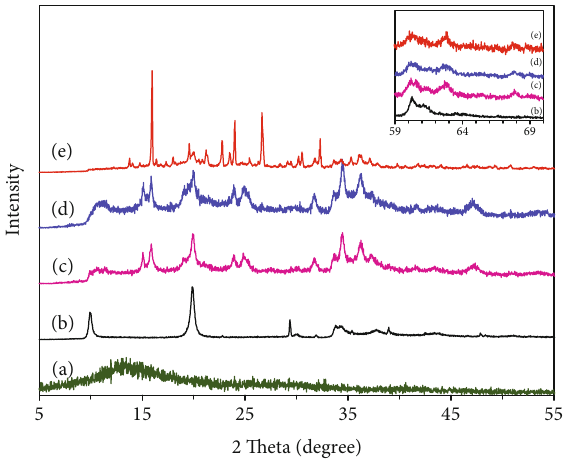
Figure 4: FT-IR spectrum of polyaniline (a), 2 Pan/MHT (b), 1 Pan/MHT (c), 0.5 Pan/MHT (d), and MHT (e).